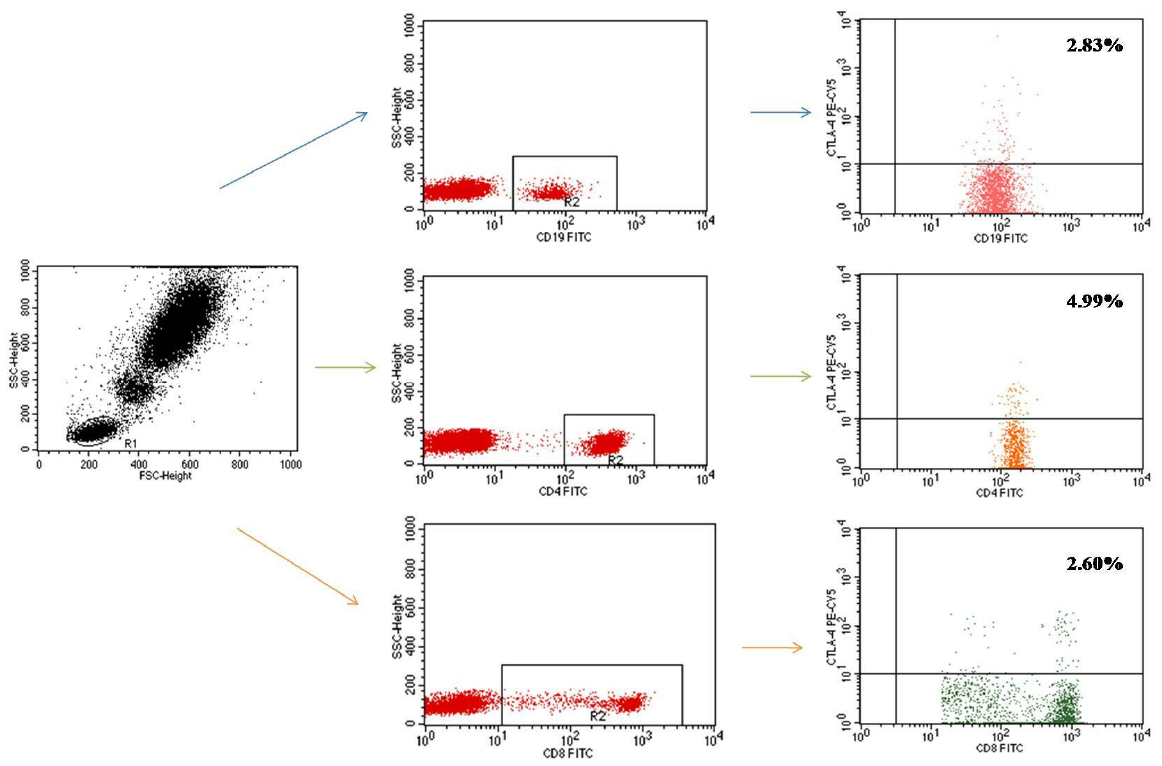
Figure 1. Evaluation of the percentage of lymphocytes (B CD19+, T CD4+, T CD8+) with CTLA-4 antigen expression in a patient with idiopathic pulmonary arterial hypertension. The signal confirming the presence of receptors on cells was present on 2.83% of CD19+ B cells, 4.99% of CD4+ T cells, and 2.60% of CD8+ T cells. Table 1. Evaluation of the percentage of CTLA-4 molecule in CHD-PAH, CTD-PAH, CTEPH and iPAH patients and